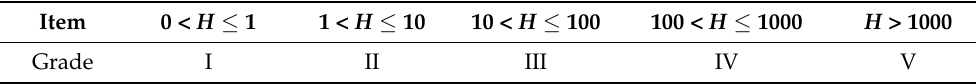
Table 2. A risk index level of MPs.